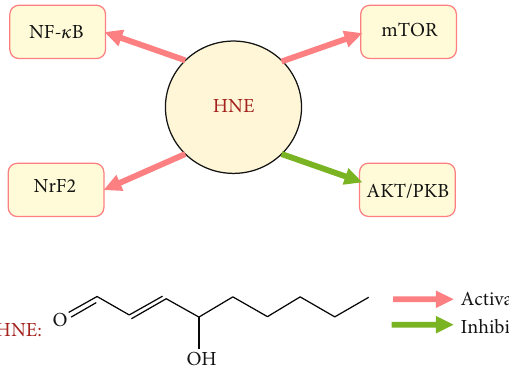
Figure 2: Summary of 4-hydroxy-2-nonenal (4-HNE) involvement in an aging-related signaling pathway. 4-HNE leading to NF- κ B, Nrf2, and mTOR pathway activation, and inhibiting AKT/PKB pathway